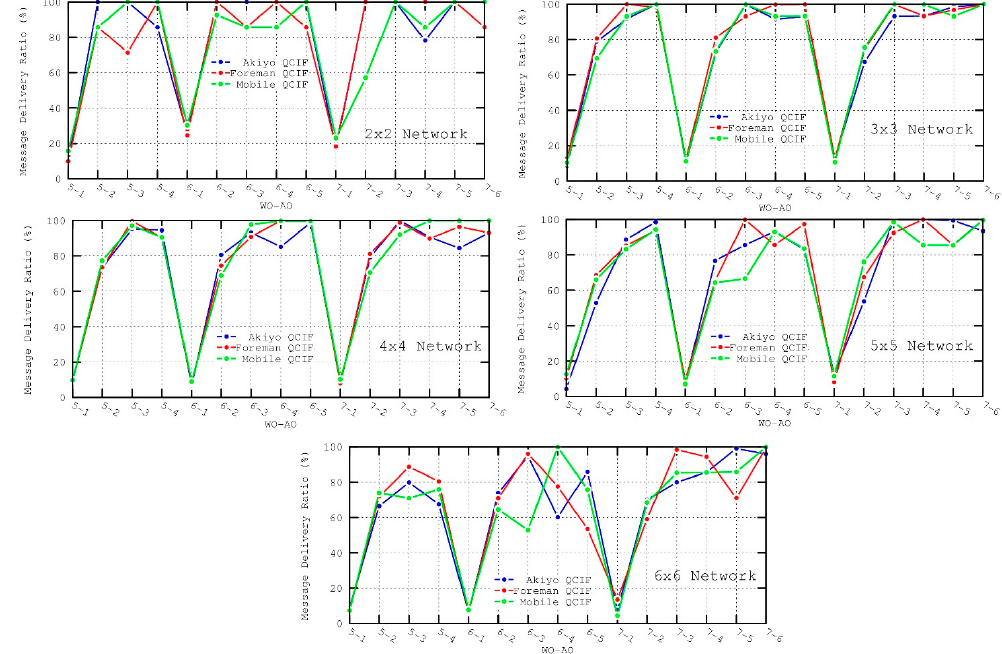
Figure 13. Message delivery ratio metric for the different scenarios.